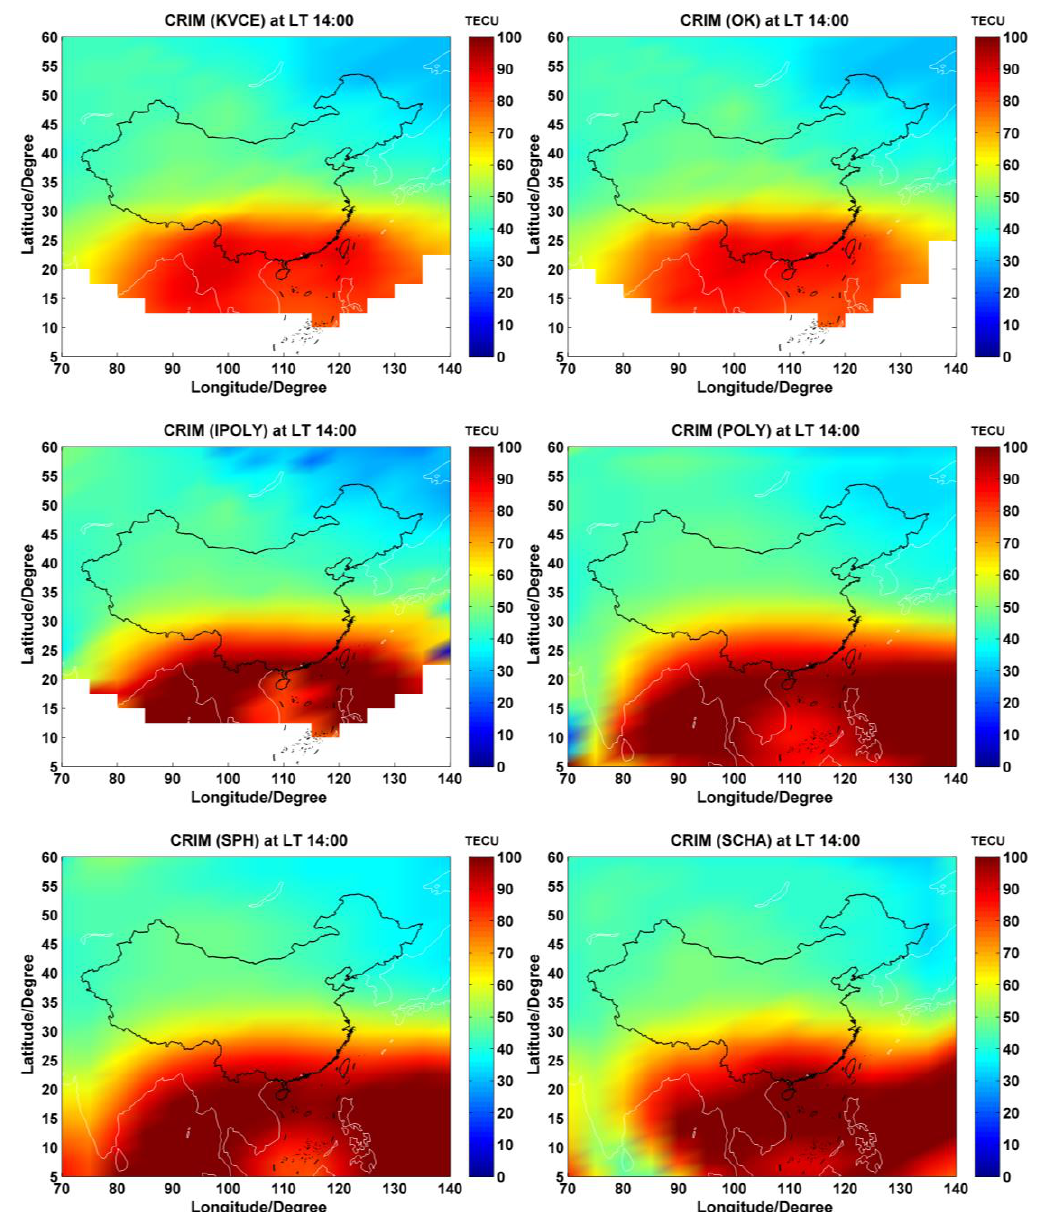
Figure 4. The VTEC maps obtained by different approaches at local time 14:00 on DOY 305 of